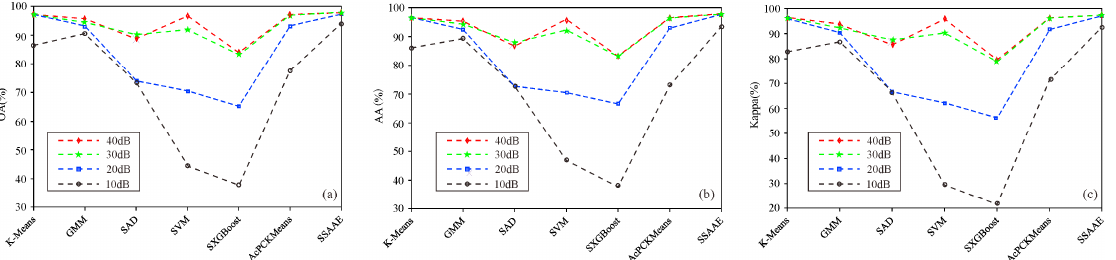
Figure 9. Maps of spectral absorption features and their correspondence to latent features. ( a ) The absorption features of the 40th mixed data at the wavelength range of 2100–2430 nm; ( b ) the corre- spondence between absorption depth (Dep2340) and the 6th latent feature (Z6); ( c ) the correspondence between absorption area (AA2340) and the 10th latent feature (Z10); ( d ) the correspondence between absorption symmetry and the 8th latent feature (Z8).